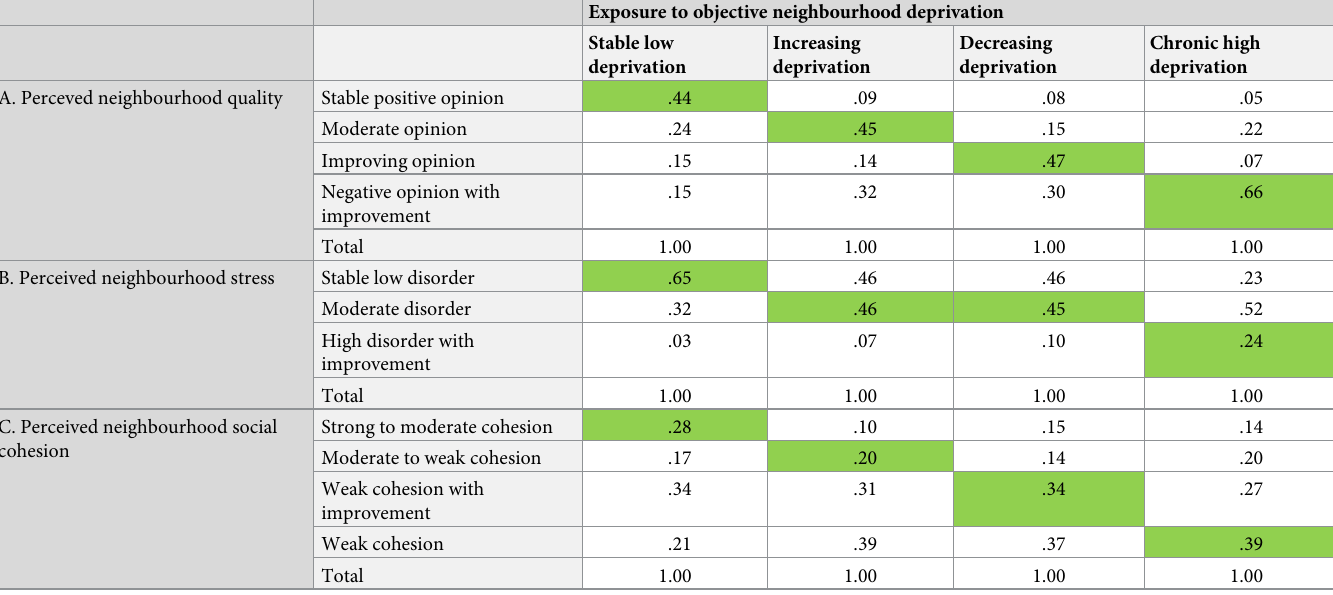
Table 5. Probability of perceived measure trajectory group conditional on objective measure trajectory